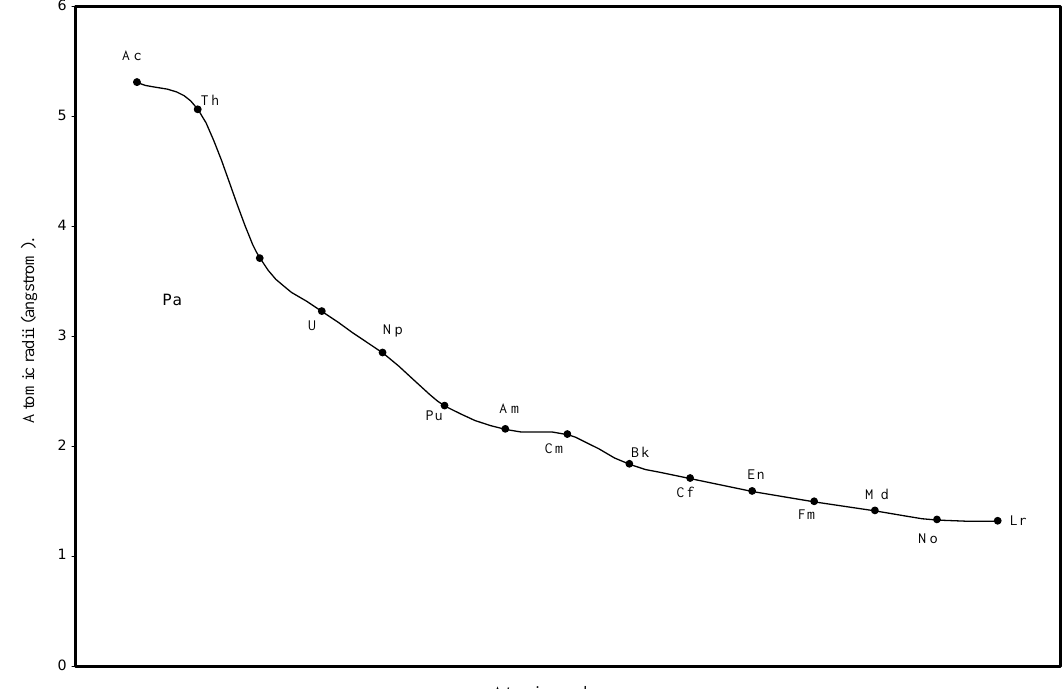
Figure 6. Plot of atomic radii of actinides in angstrom unit as a function of Atomic number. (A) Diamagnetic part of magnetic susceptibility, χ